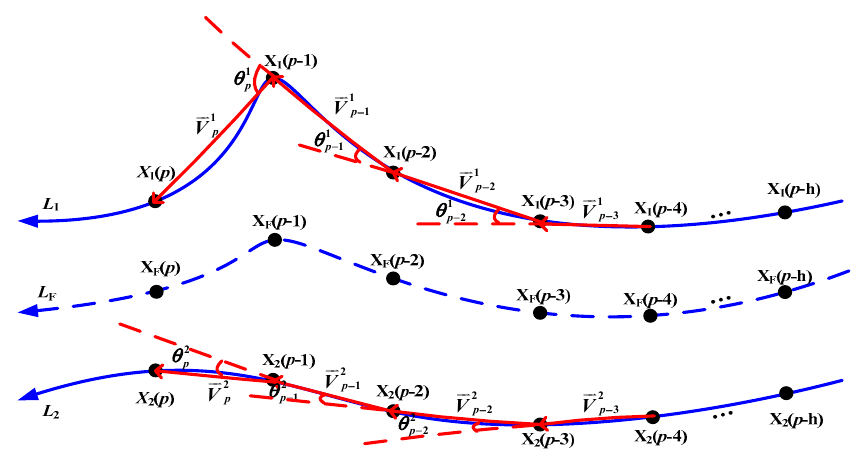
Figure 1. The reconstructed phase trajectory L 1 and L 2 , and the fused trajectory L F to illustrate the basic idea of the novel data fusion algorithm (NDFA).